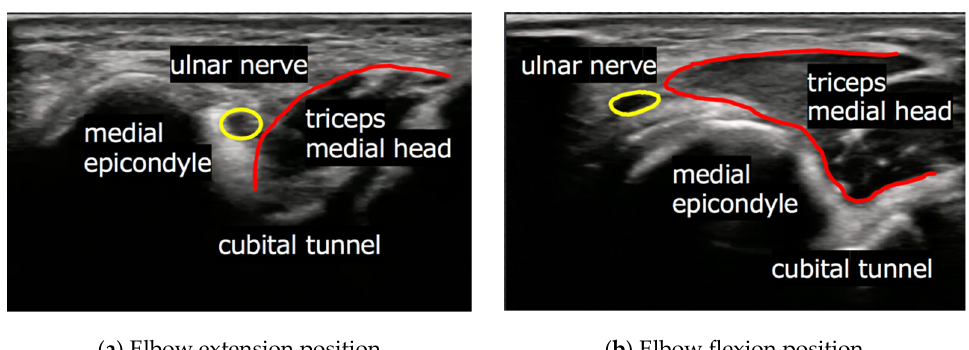
Figure 2. Short-axis images at the cubital tunnel using ultrasonography. ( a ) Elbow extension position and ( b ) elbow flexion position: push-out of the ulnar nerve by the triceps medial head from the cubital tunnel.